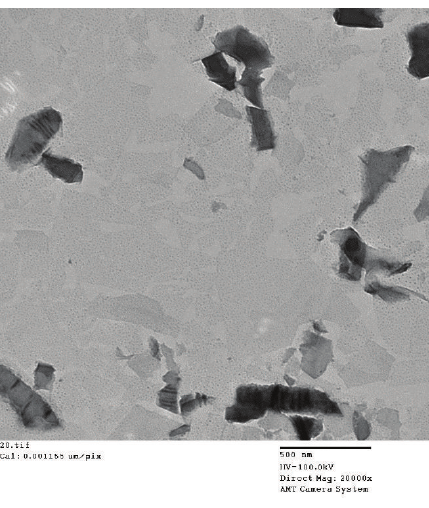
Figure 2: TEM of exfoliated titania nanosheets.